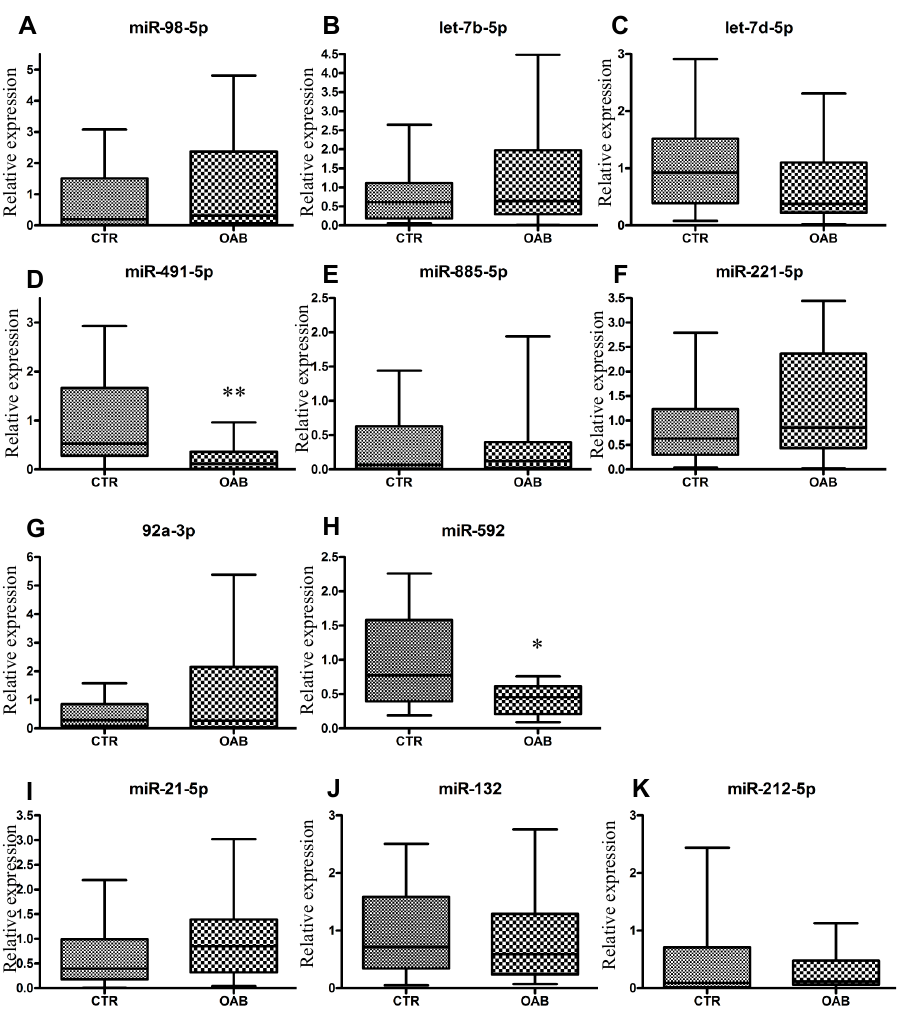
Figure 1. Urinary microRNA expression in control (CTR) and OAB patients. Mean expression levels of urinary miRNA ( A to K ) were determined by RT-qPCR using the 2 −ΔΔ CT method. The midline in the box and whisker plots depicts the median with upper and lower limits representing the minimum and maximum value minus the outliners; * p < 0.05, ** p < 0.005. Subsequently, we analyzed two miRNAs involved in the translation of MMP-9, the main protease digesting mature NGF [21]. The MMP-9 mRNA UTR-3 ′ region is directly bound by miR-491-5p [22]. The miR-885-5p targets the expression of genes upstream of MMP-9, eventually reducing MMP-9 expression [22]. MiR-491-5p levels were decreased by 71% in the OAB group as compared to the control group ( p = 0.005) while miR-885-5p was not affected (Table 2, Figure 1). These results highlight the complexity of miRNA gene regulation, depending on whether the control is direct or upstream of the target gene. Interestingly, urinary MMP-9 enzymatic activity was reported to be significantly higher in OAB patients compared to the control group [12], an increase that could be explained at least in part by the loss of miR-491-5p post-transcriptional control. The p75 NTR mRNA has a conserved miR-592 binding sequence [23], while TrkA mRNA expression is correlated with miR-221-5p and miR-92a-3p [24,25]. Accordingly, an inverse correlation between miR-592 and p75 NTR expression has been demonstrated. We found here that the level of miR-592 in the OAB group was decreased by 48% compared to the controls ( p = 0.010), suggesting an upregulation of p75 NTR (Table 2, Figure 1). On the